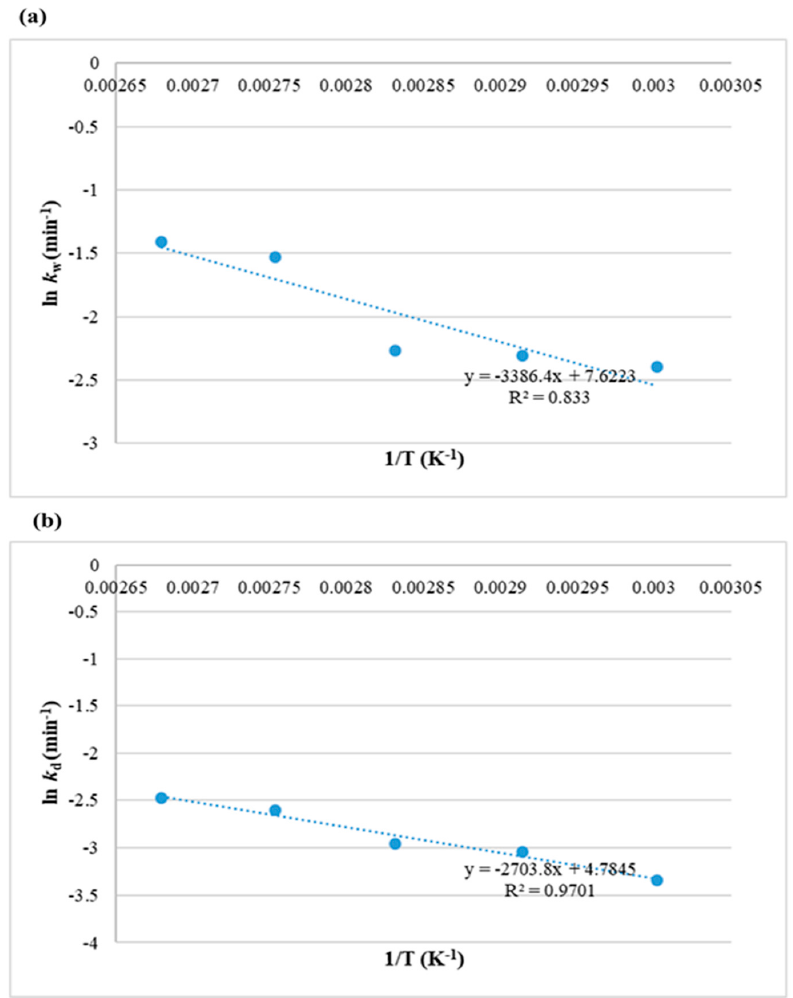
Figure 7. Relationship between temperature and Patricelli kinetic model coefficients at different phases ( a ) washing phase and ( b ) diffusion phase, for extraction of lipids from Nannochloropsis sp. microalgae using MAE-brine.